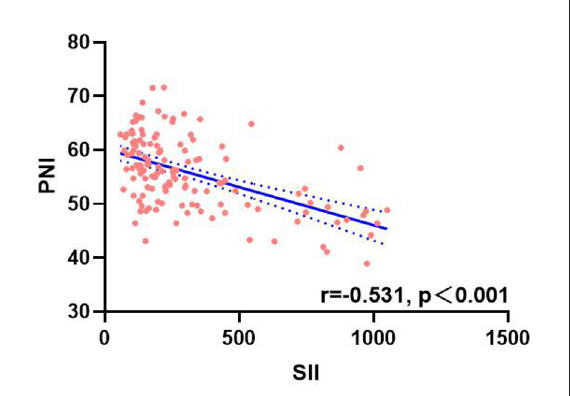
FIGURE2 Correlation analysis between SII and PNI. SII, systemic inflammatory immunity index; PNI, prognostic nutritional index.